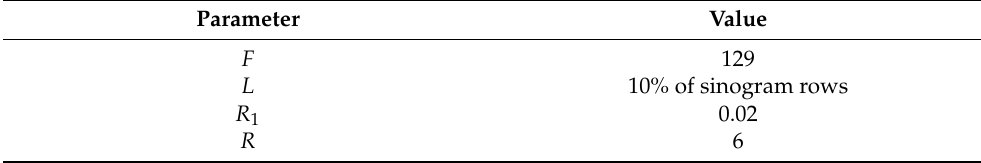
Table A4. LRA removal algorithm settings.